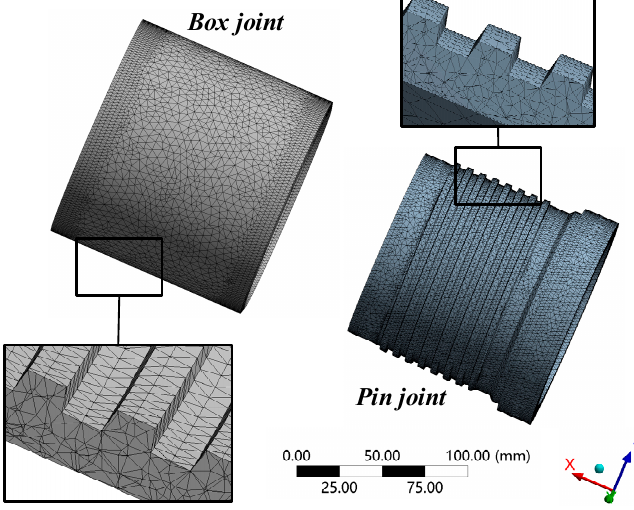
Figure 5. Meshed models of the pin joint and box joint.